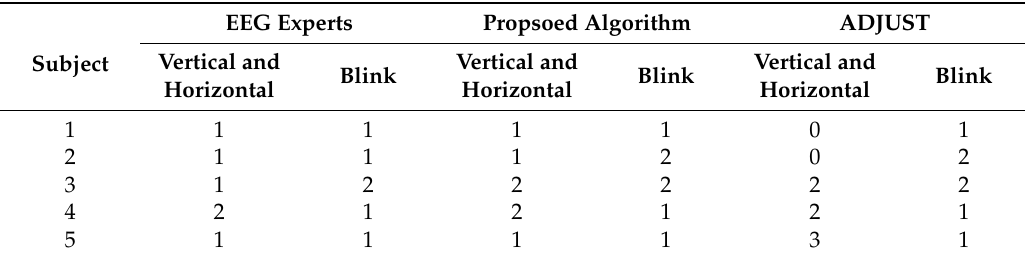
Table 4. Comparison results for identification of artifactual